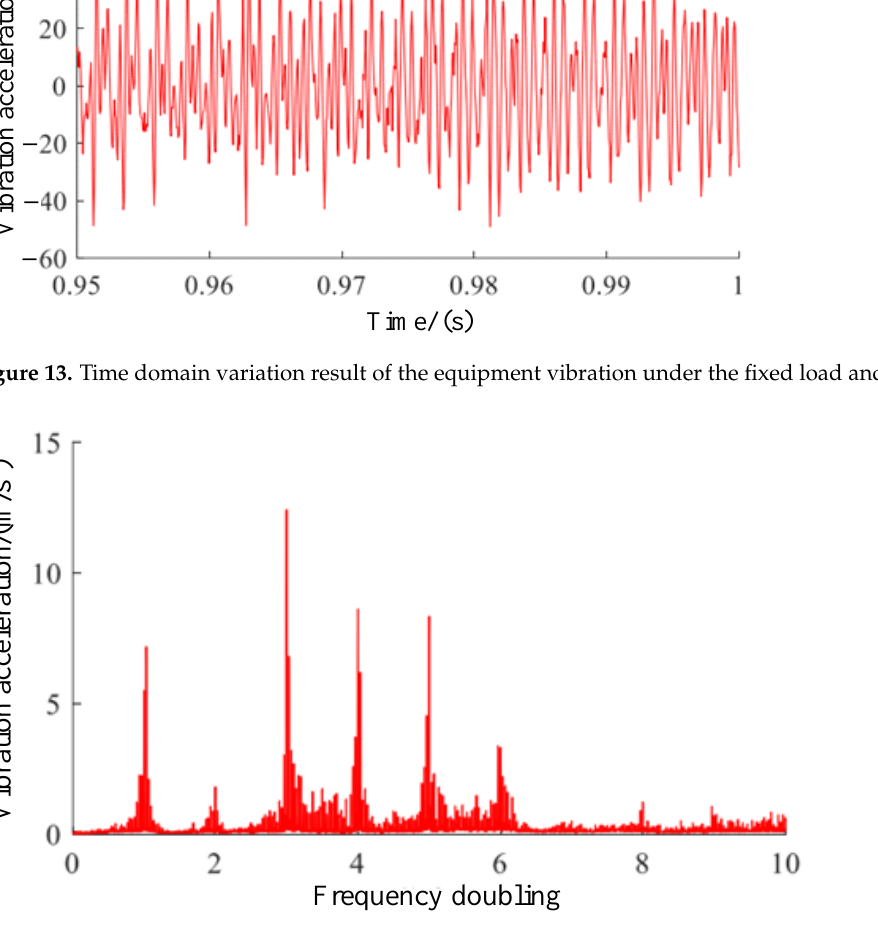
Figure 14. Frequency domain variation result of the equipment vibration under the fixed load and speed.